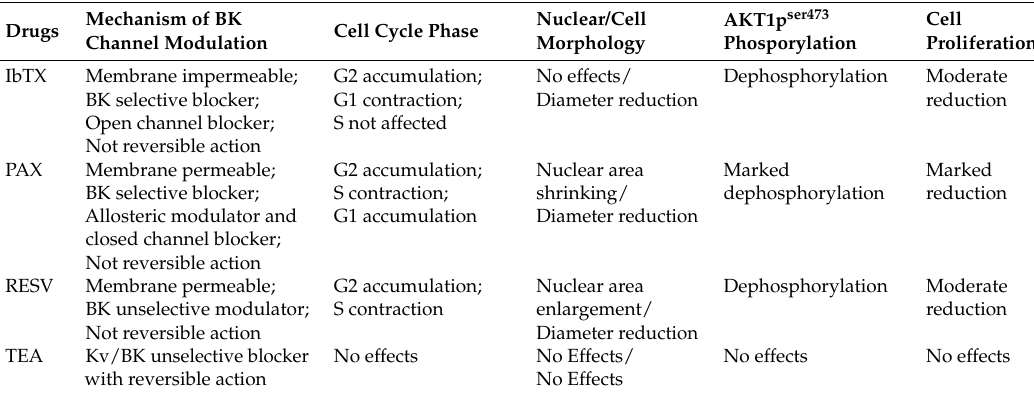
Table 1. Summary of the effects of the BK channel modulator on cell cycle progression, morphology, and proliferation in SH-SY5Y cells after 6 h of